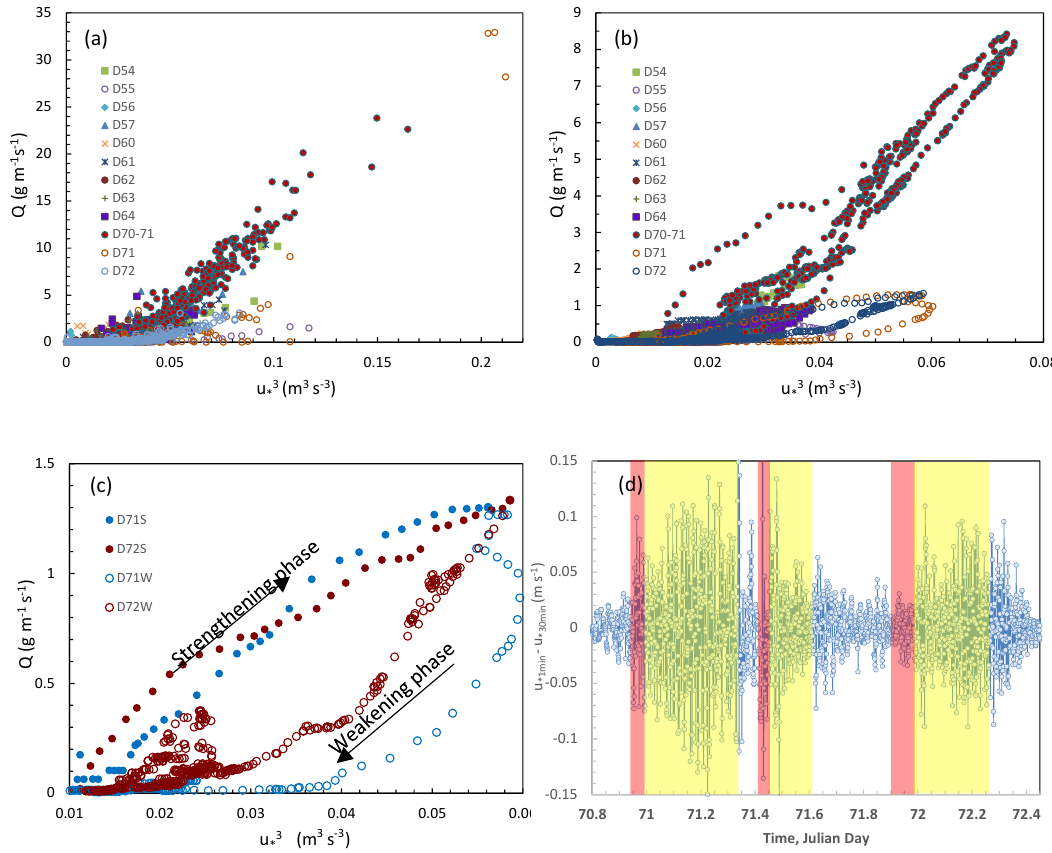
Figure 3. (a) Saltation flux, Q (gm − 1 s − 1 ) , plotted against friction velocity, u 3 ∗ (m 3 s − 3 ) , for 1min averages. (b) As (a) but for 30min averages. (c) As (b) but enlarged to illustrated saltation hysteresis on D71 and 72; D71S/72S denotes the strengthening phase and D71W/72W the weakening phase of the D71/72 event. (d) Time series of u ∗ derivations, given by ( u ∗ 1min − u ∗ 30min ) , for D70-71, D71 and D72. The strengthening phase is marked red and the weakening phase is in yellow.